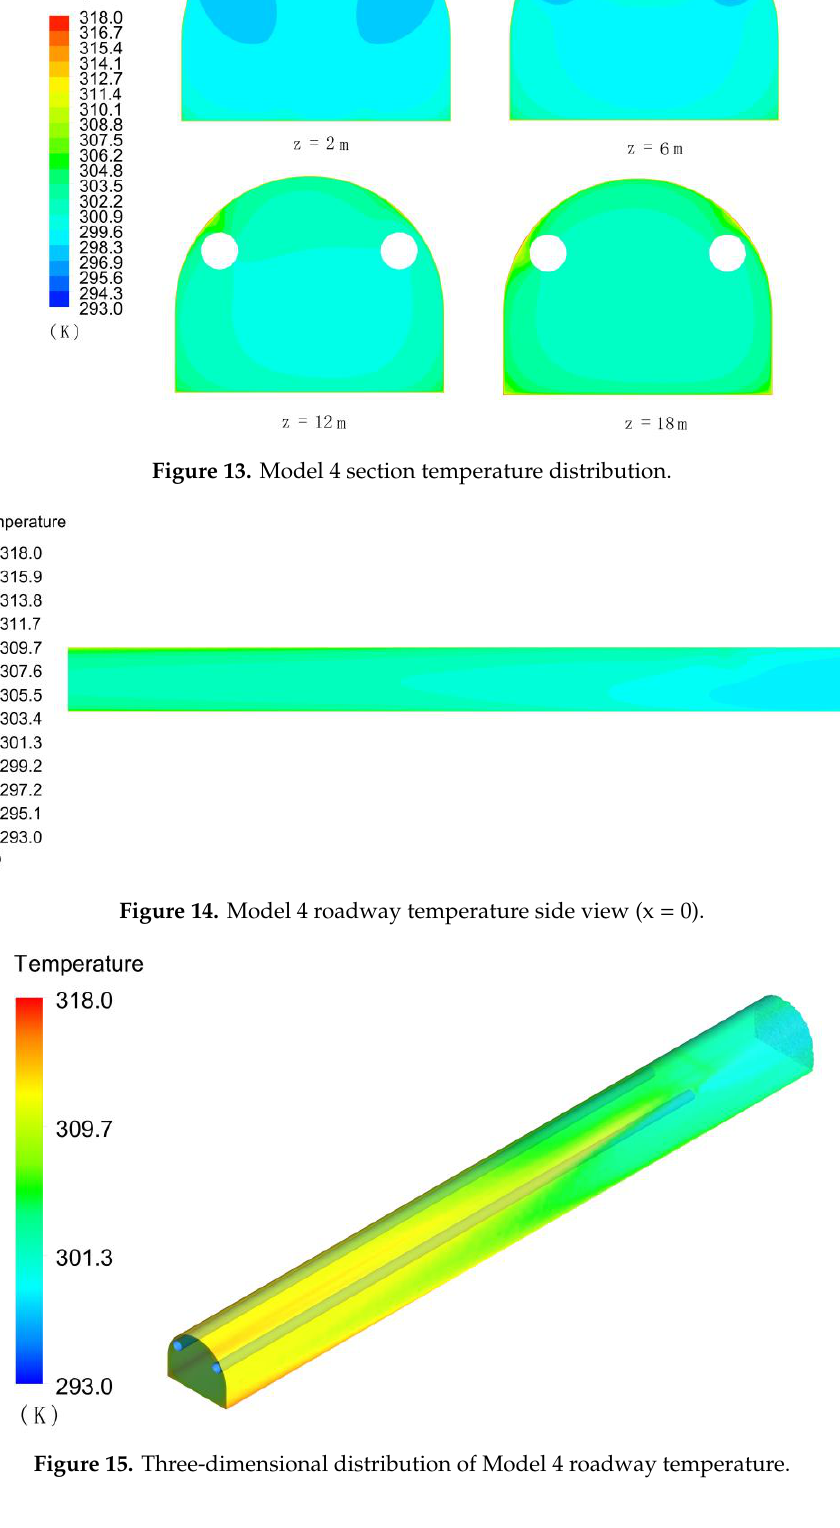
Figure 15. Three-dimensional distribution of Model 4 roadway temperature.